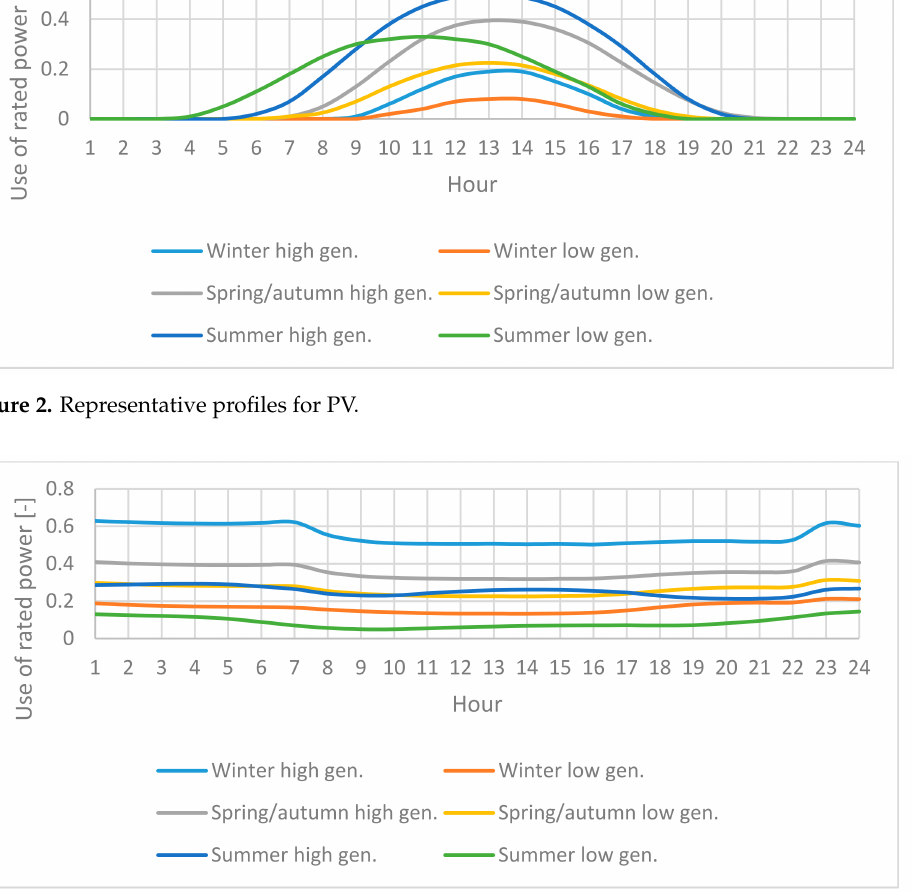
Figure 3. Representative profiles for